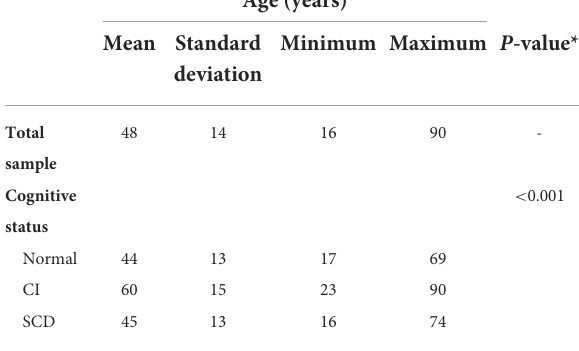
TABLE 7 Total sample age and according cognitive